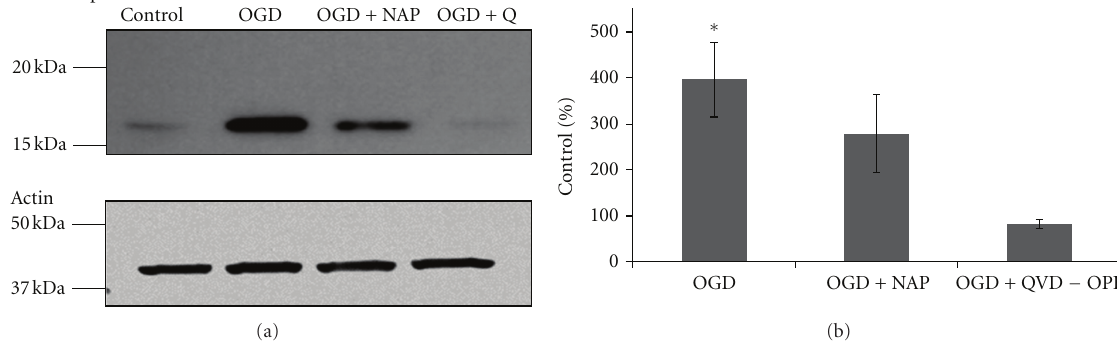
Figure 4: An increase in active caspase-3 levels induced by 2 hours of OGD was diminished by NAP treatment (10 − 5 M). Cultures were treated with 10 − 5 M NAP or with 20 μ M QVD-OPH (broad spectrum caspase inhibitor) exposed to OGD insult for 2 hours. Proteins were extracted and analyzed using immunoblot with a specific antiactive caspase-3 antibody. A representative blot of active caspase-3 antibody is exhibited in (a). (ANOVA with post hoc LSD, P ≤ 0 . 05) (b).